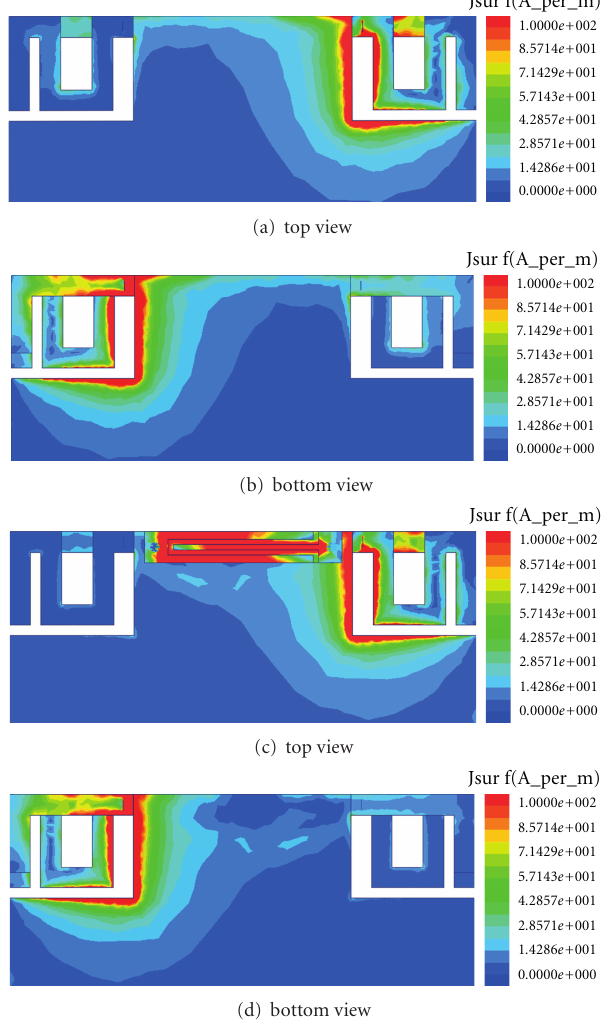
Figure 6: Simulated current distribution: (a)-(b) without interdig- ital SRR, (c)-(d) with interdigital SRR.